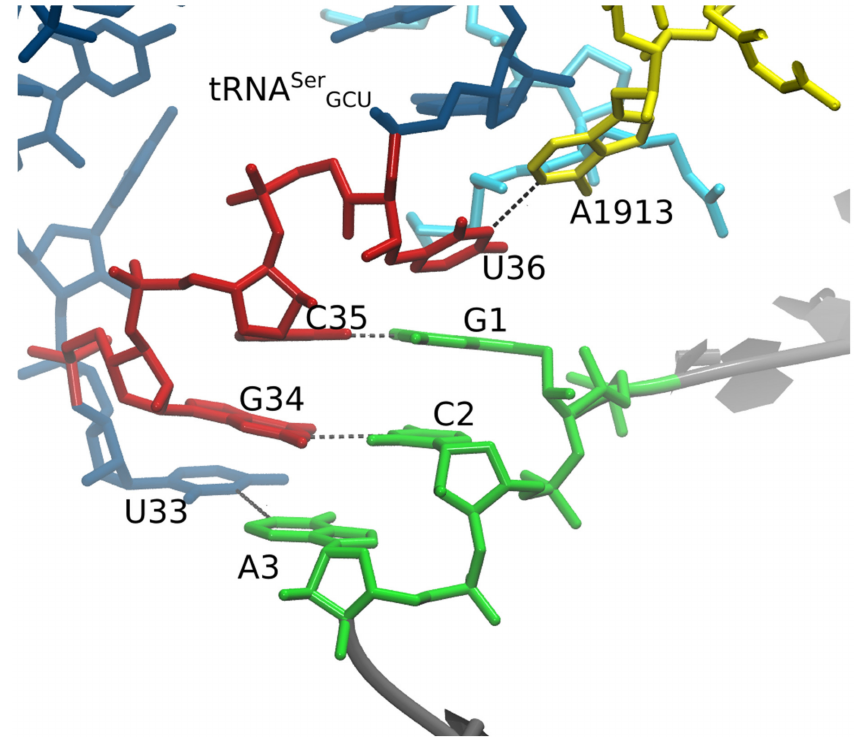
Figure 4. Grapple hypothesis. In this model, we enforced a U36 – A1913 base pair and U33 “grapple” Watson–Crick to Watson–Crick base pair with A3. The U33 / A3 interaction was not maintained in the MD simulation. A1913 is a 23S subunit residue, whereas our experiments included only the small